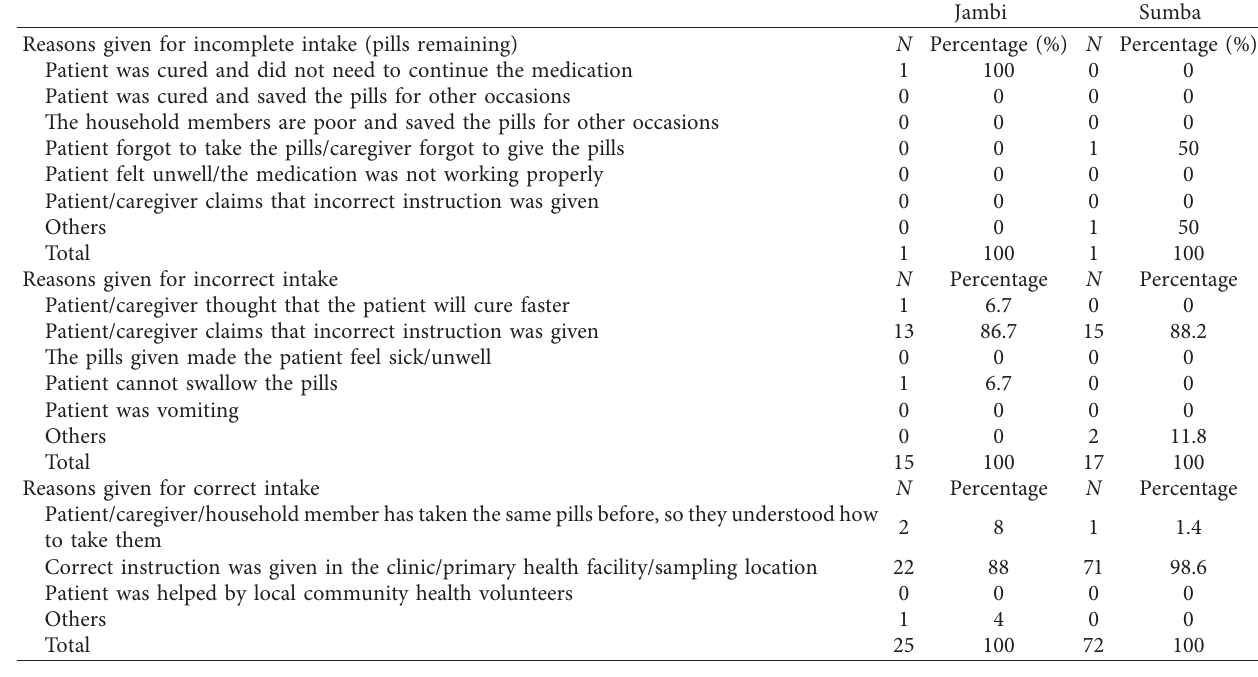
Table 4: Reason for incomplete, incorrect, and correct intake given by the